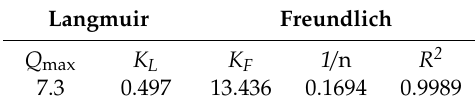
Table 5. Isotherms parameters for the adsorption of AB92 onto Nd 2 O 3